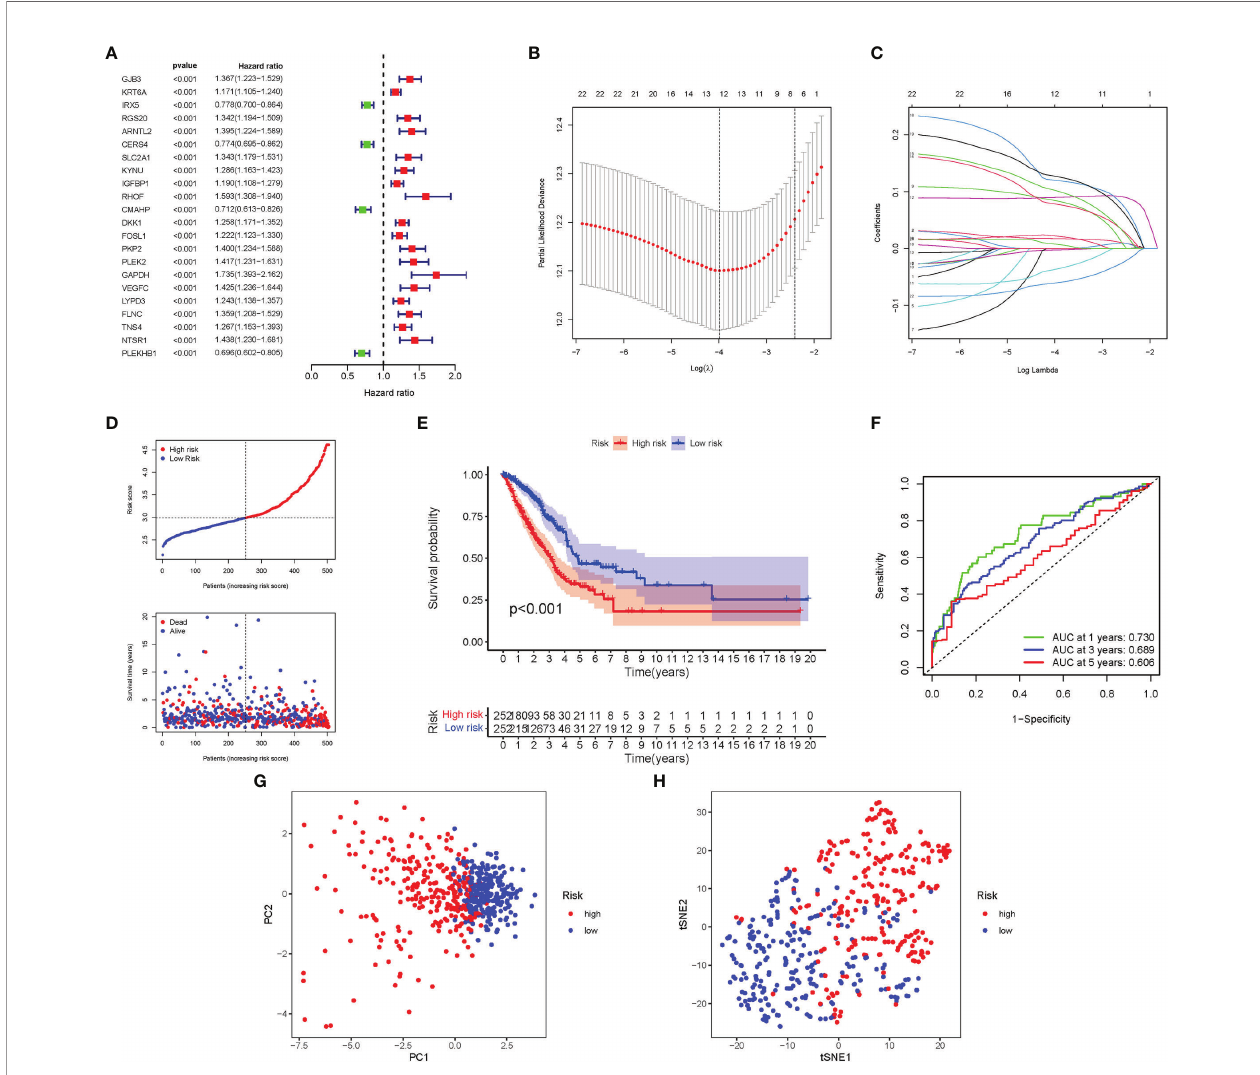
FIGURE 5 | Construction of risk signature in the TCGA cohort. (A) A univariate Cox regression analysis of OS for each participating in autophagy gene and 22 genes with P < 0.01. (B) LASSO regression of the 22 OS-related genes. (C) Cross-validation for tuning the parameter selection in the LASSO regression. (D) The survival status for each patient (low-risk population: on the left side of the dotted line; high-risk population: on the right side of the dotted line). (E) Kaplan – Meier curves for the OS of patients in the high- and low-risk groups. (F) The AUC of the prediction of 1-, 2-, 3-year survival rate of LUAD. (G) PCA plot for LUADs based on the risk score. (H) t-SNE plot for LUADs based on the risk